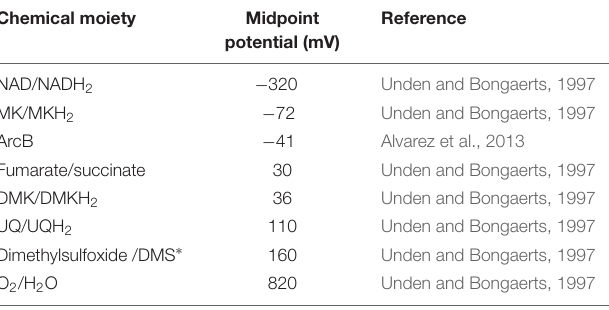
TABLE 1 | Midpoint potential of various redox couples relevant for this